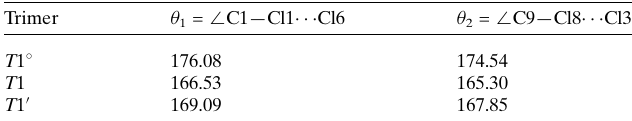
tion between Cl (cid:2) (cid:2) (cid:2) (cid:2) and type II Cl (cid:2) (cid:2) (cid:2) Cl interactions, which